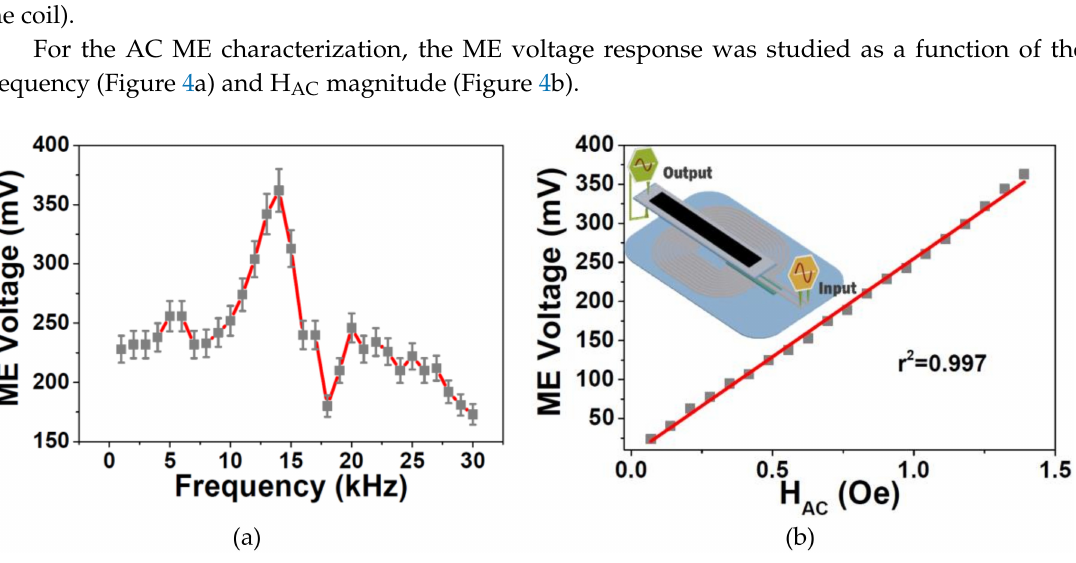
Figure 4. Magnetoelectric (ME) voltage response as a function of: ( a ) frequency and ( b ) H AC magnitude value generated by the printed